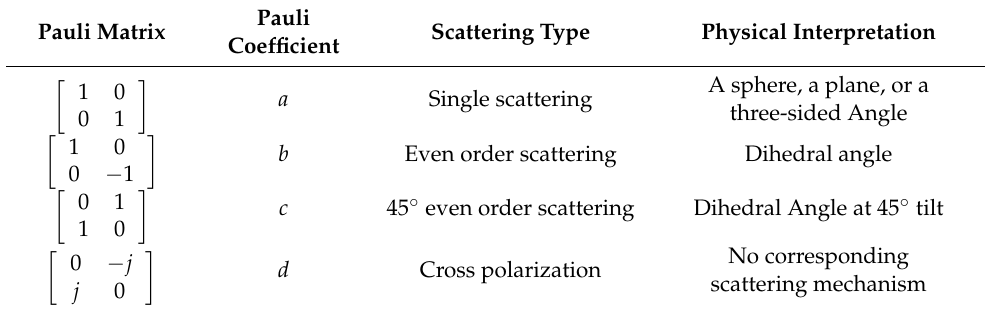
Table 2. The physical explanation of Pauli decomposition. Pauli Scattering Type Physical Pauli Matrix Coefficient